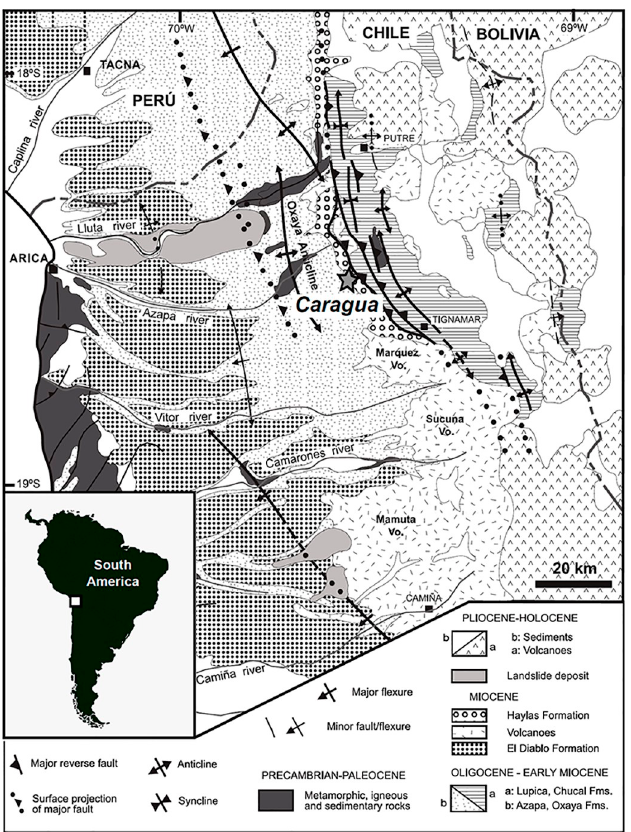
Fig 1. Geographic and geological map. Geographic and geological setting of the Caragua fossil locality (star), in northern Chile, showing the main lito-stratigraphic units and structural features; adapted from Garcı´a et al. [48].